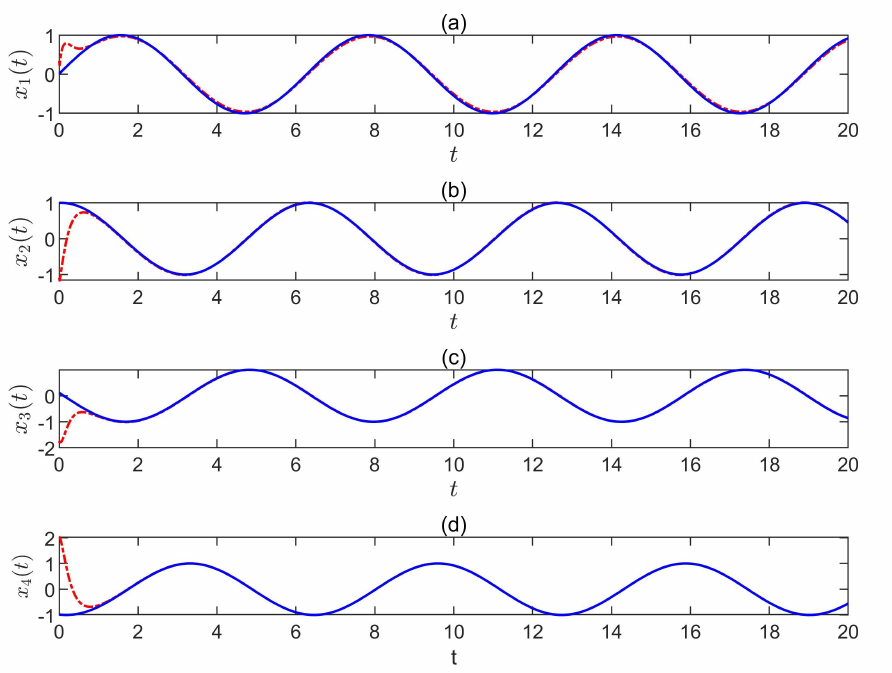
Figure 1. The state trajectories of the system: ( a ) the x 1 , x 1 R − t space; ( b ) the x 2 , x 2 R − t space; ( c ) the